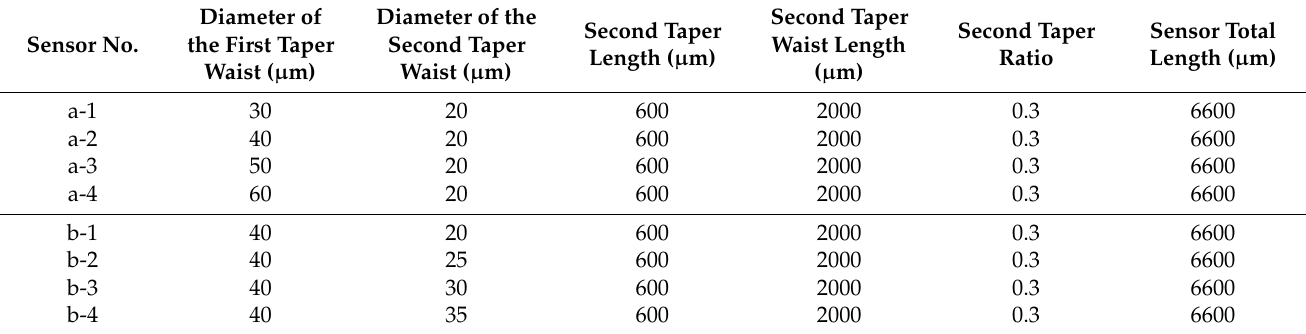
Table 1. Tapered fiber sensors with various diameters of first and second taper waist.